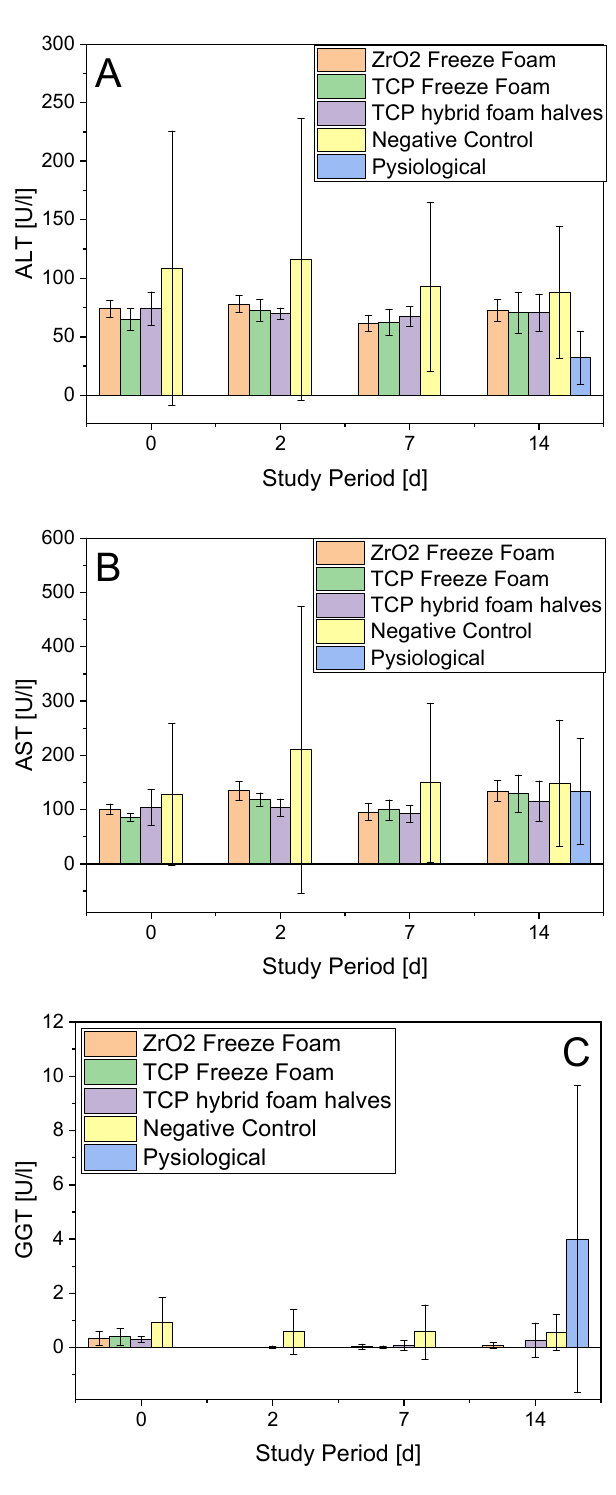
Figure 17. Course of ( A ) ALT, ( B ) AST and ( C ) GGT over the study period of 14 d; for clarity, the physiological control values were only entered for day 14. Physiological values taken from Giknis et al. [34] (ALT, AST) and Boehm et al. [35] (GGT). 3.4.2. Creatinine Kidney creatinine (crea, long-term) and urea (short-term) values stayed under the references in all rats of all groups at all time points (Figure 18). As values depend heavily on the method used for their determination, the engaged laboratories have their own ref- erences. Since no references were sent by the clinic as stated above, we compared the de- termined values of creatinine and urea with references [34] and [35]. This might be an explanation for the lower values. However, as the kidney values did not show any in- creases over the time, this shows that the implants did not have a negative influence on the kidneys. Nevertheless, regarding proof of a non-toxic effect, long-term additional histo- logical examinations of the removed kidneys, in line with the 3R principles, must be exe- cuted. 0 2 7 14020060080012001400 CR EA [ µ m o l / l ]